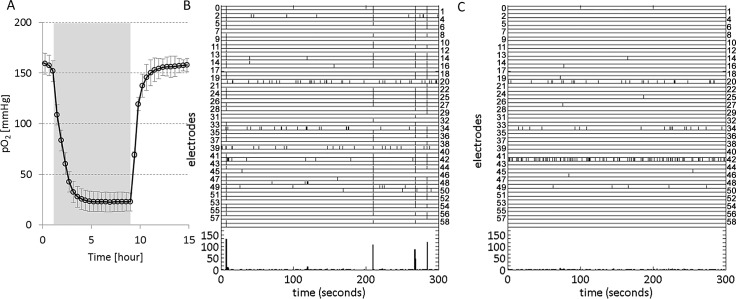
Temporal evolution of the partial oxygen pressure (pO2) in an MEA filled with R12 at 36°C, containing a cortical culture and raster plots during normoxia and hypoxia.A: pO2 was measured in an MEA with a cortical culture, placed under a Plexiglas hood that received a continuous gas flow of 4.7 L/min. The gas mixture was either normoxic (95% air and 5% CO2), or hypoxic (85% N2, 10% air and 5% CO). Filled background indicates period of hypoxic gas flow, referred to as hypoxic period. Curve shows the average of 3 measurements, error bars indicate SD. B, C: Activity raster plots during normoxia (A) and hypoxia (B), recorded in one culture. Vertical axes indicate electrode numbers, each tick marks an action potential at the electrode number indicated on the left or right of the row. The bottom part of both panels shows total activity in 1 s bins. Under normoxic conditions, synchronous network bursts were regularly observed (e.g. at t = 10s or t = 210s in panel B). Under hypoxic conditions, typically the array wide firing rate decreased, as well as the synchronicity between electrodes. Occasionally, a small number of neurons (<5) displayed increased, uncorrelated firing, e.g. electrode 42 in panel C.